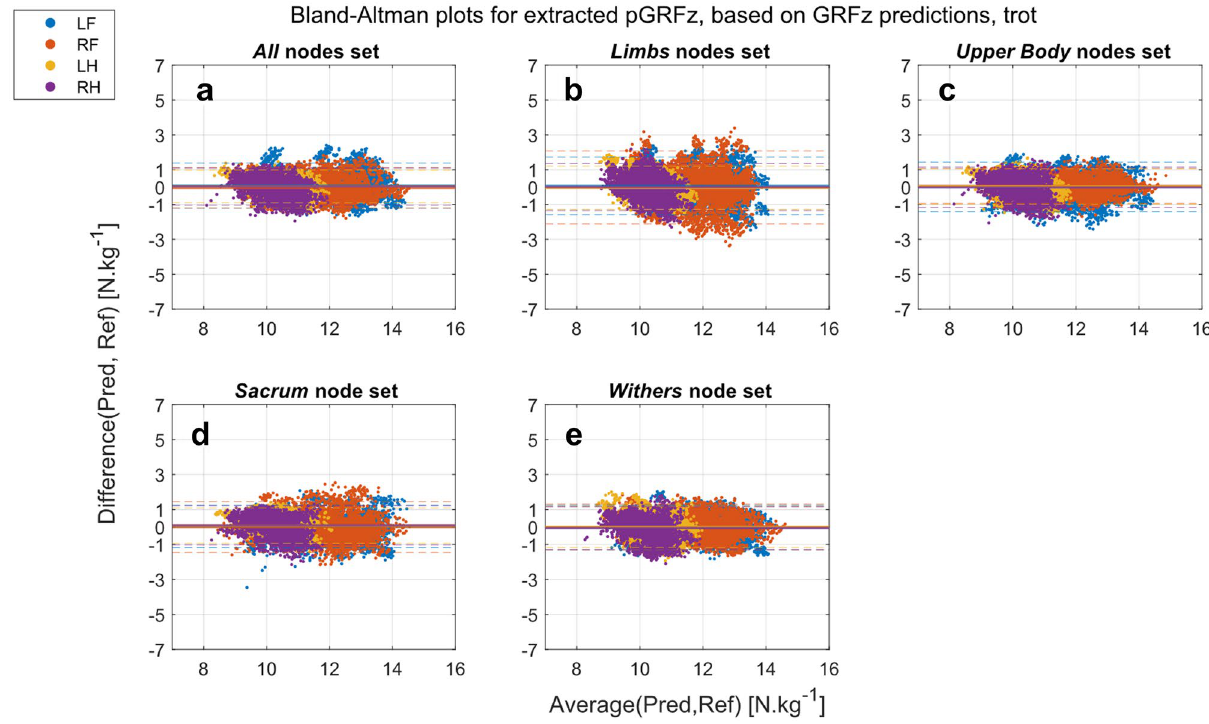
Figure 5. Bland–Altman plots of pGRFz extracted from the GRFz curves predicted by the different nodes sets at trot (Pred) against the reference values extracted from the TiF data (Ref): ( a ) All (head, withers, sacrum, and limb nodes); ( b ) Limbs (limb nodes); ( c ) Upper-body (head, withers and sacrum nodes); ( d ) Sacrum (sacrum node); ( e ) Withers (withers node). LF left front, RF right front, LH left hind, RH right